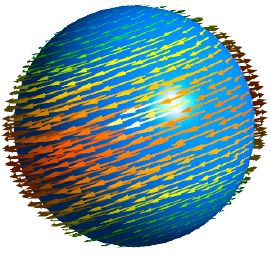
Figure 13. Surface streamline with ball spin.